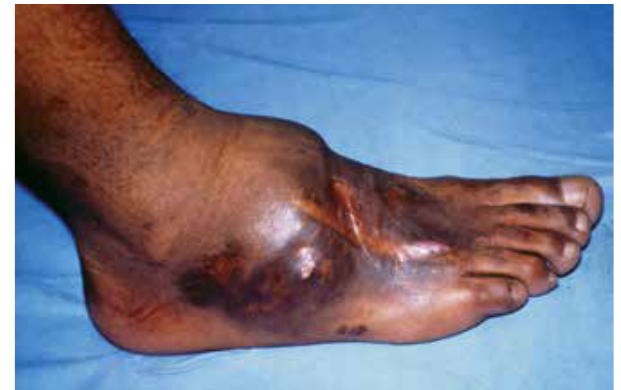
Figure 9: Actinomycetoma of the right foot, with yellowish granules being drained by the sinuses